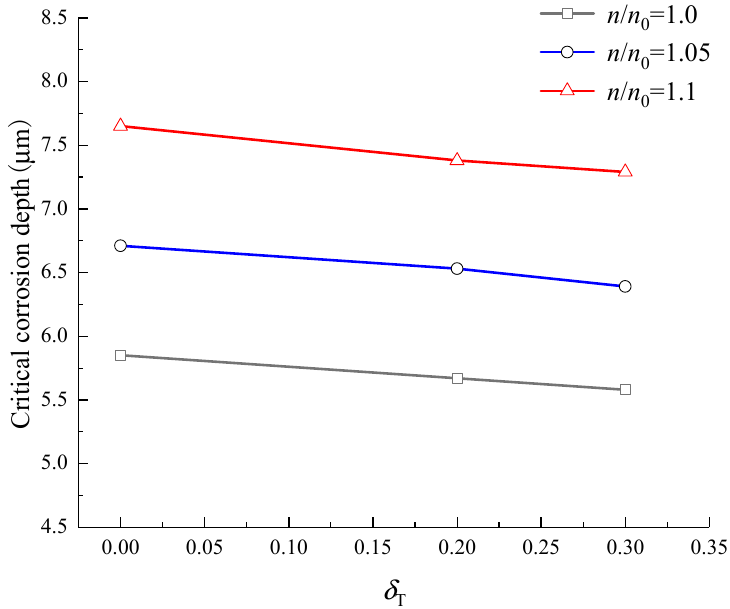
Figure 12. Critical corrosion depth of steel bars when the CCS cracks. Figure 12 illustrates that the load affects the critical corrosion depth of the steel bars when the CCS cracks, but the effect is not significant. The larger the load, the smaller the critical corrosion depth of the steel bars. The larger the n / n 0 , the more rust filled into the pores of concrete around steel bars, resulting in a larger critical corrosion depth of the steel bars. For the three cases of δ T = 0, 0.2, and 0.3, when the n / n 0 increases from 1.0 to 1.1, the critical corrosion depth of steel bars increases by 30.8%, 30.2%, and 30.6%, respectively. For the three cases of n / n 0 = 1.0, 1.05, and 1.1, when the tensile stress level δ T increases from 0 to 0.3, the critical corrosion depth of the steel bars decreases by 4.6%, 4.8%, and 4.7%, respectively. Apparently, the value of n / n 0 , that is, the influence of the rust-filling layer on the critical corrosion depth of the steel bars is greater than that of the load. Compared with the analysis results of Section 4, it can be found that the influence of the load on the critical corrosion depth of the steel bars when the IBSC cracks is larger than that of when the CCS